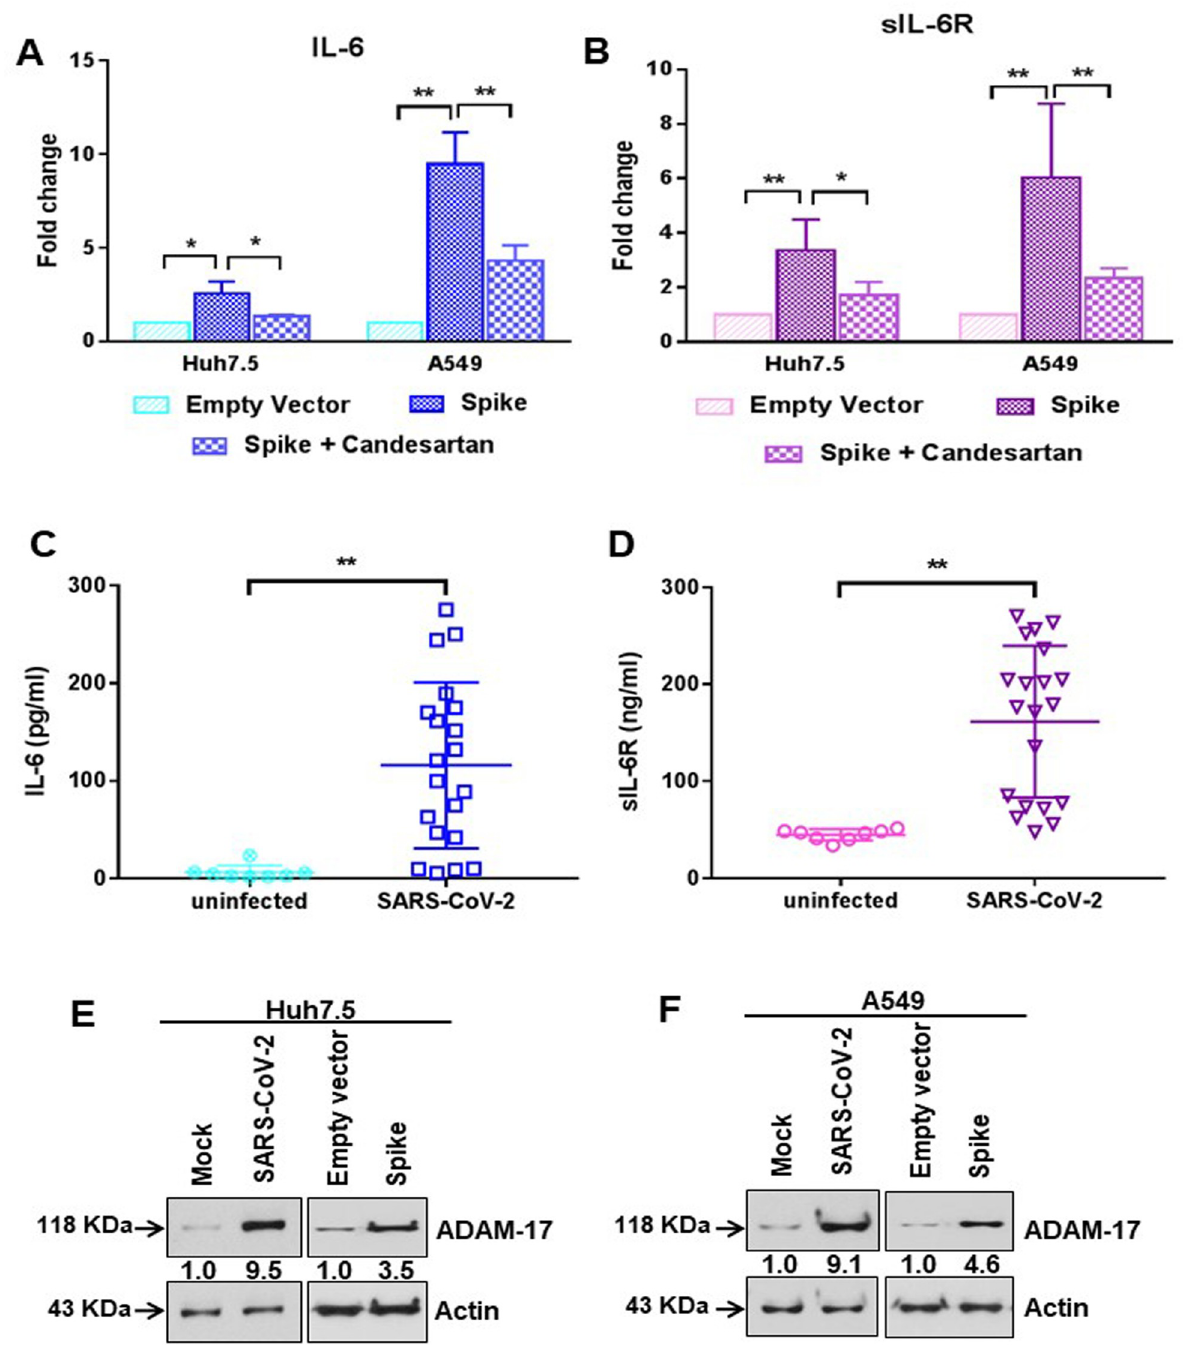
Fig 4. SARS-CoV-2 spike protein stimulates IL-6 and soluble IL-6R production. (A) The extra-cellular level of IL-6 was measured by ELISA from culture supernatant of Huh7.5 and A549 cells after transfection of SARS-CoV-2 spike gene construct with or without Candesartan cilexetil treatment. (B) The extra-cellular level of soluble IL-6R was similarly measured by ELISA from culture supernatant of Huh7.5 and A549 cells after transfection of SARS-CoV-2 spike gene construct with or without Candesartan cilexetil treatment as shown in panel A. The results are presented as means ± standard deviations. ‘ � ’ and ‘ �� ’ represent statistical significance p < 0.05 and p < 0.005, respectively. (C) The level of IL-6 was measured by ELISA from the serum samples of SARS-CoV-2 infected patients (n = 20) and uninfected healthy volunteers (n = 8). (D) The level of soluble IL-6R was similarly measured by ELISA from the serum samples of SARS-CoV-2 infected patients (n = 20) and uninfected healthy volunteers (n = 8) as shown in panel C. The results are presented as means ± standard deviations. ‘ � ’ and ‘ �� ’ represent statistical significance p < 0.05 and p < 0.005, respectively. (E, F) Western blot analysis of ADAM-17 expression in Huh7.5 and A549 cell lysates prepared after 48 h of mock-treated or infected